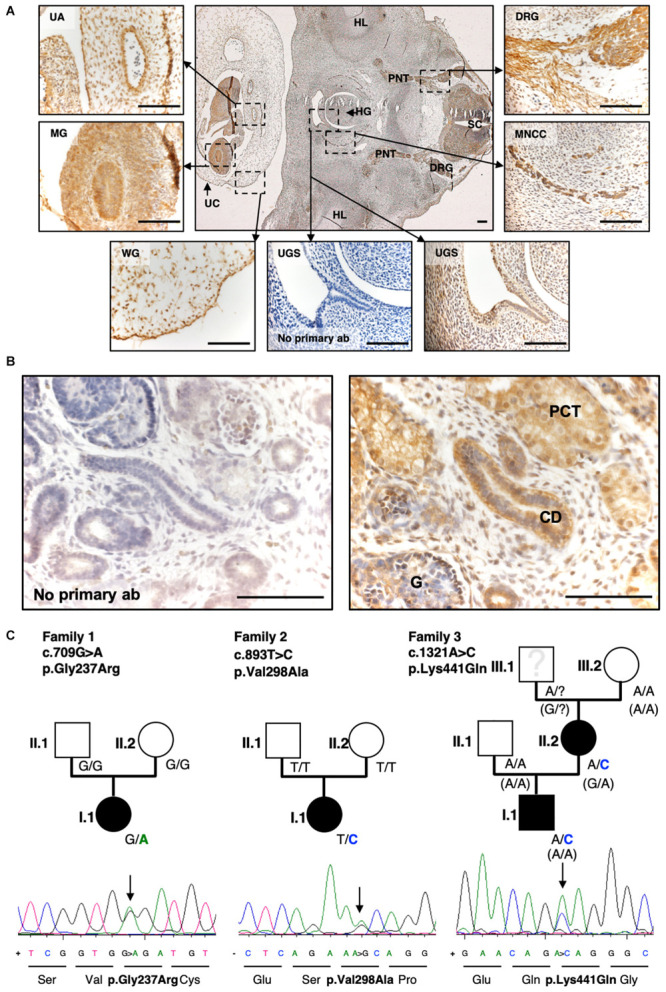
Exome sequencing and targeted Resequencing in families with BEEC phenotype identified disease variants in SLC20A1.
(A) IHC of a transverse section of a 6-week-old human embryo. SLC20A1 was immunodetected (brown) in the urogenital sinus (UGS), which develops into the urinary bladder. Furthermore, (textitSLC20A1 was also detected in the spinal cord (SC), dorsal root ganglia (DRG), peripheric nerve trunk (PNT), hind limb (HL), hindgut (HG), migrating neural crest cells (MNCC), umbilical cord (UC), Wharton’s jelly (WG), midgut (MG), and umbilical artery (UA). Scale bars = 100 μm. (B) Histology section of the human 10-week-gestation metanephric metanephros. Note prominent SLC20A1 immunostaining (brown) in the proximal tubule (PT) and the collecting duct (CD). The glomerulus (G) shows a fainter signal. Scale bars: 100 μm. (C) Exome sequencing of eight CE case-parent-trios revealed de novo variant c.709G > A (p.Gly237Arg) in SLC20A1 in family 1 (Reutter et al., 2016). Resequencing of 690 individuals with BEEC led to identification of two more variants in individuals with CBE: c.893T > C (p.Val298Ala) in family 2 as de novo change c.1321A > C (p.Lys441Gln) with maternal inheritance (maternal phenotype: fusion defect of pelvic bone, mild phenotype) in family 3. Pedigrees of all three families are shown with genotypes of all individuals indicated. In family 3, the maternal grandfather (Figure 1B, family 3, person III.1) was not available for testing. For haplotype analysis of all available family members (Figure 1B, family 3, III.2, II.1, II.2, I.1), we used the synonymous marker rs4849091 at chromosomal position chr2:113404708 A > G (p.Leu101=) of the canonical transcript ENST00000272542.7. Genotypes of rs4849091 are shown in brackets. All variants are heterozygote changes and result in missense variants as shown in Sanger sequences including amino acid sequences below each pedigree.)